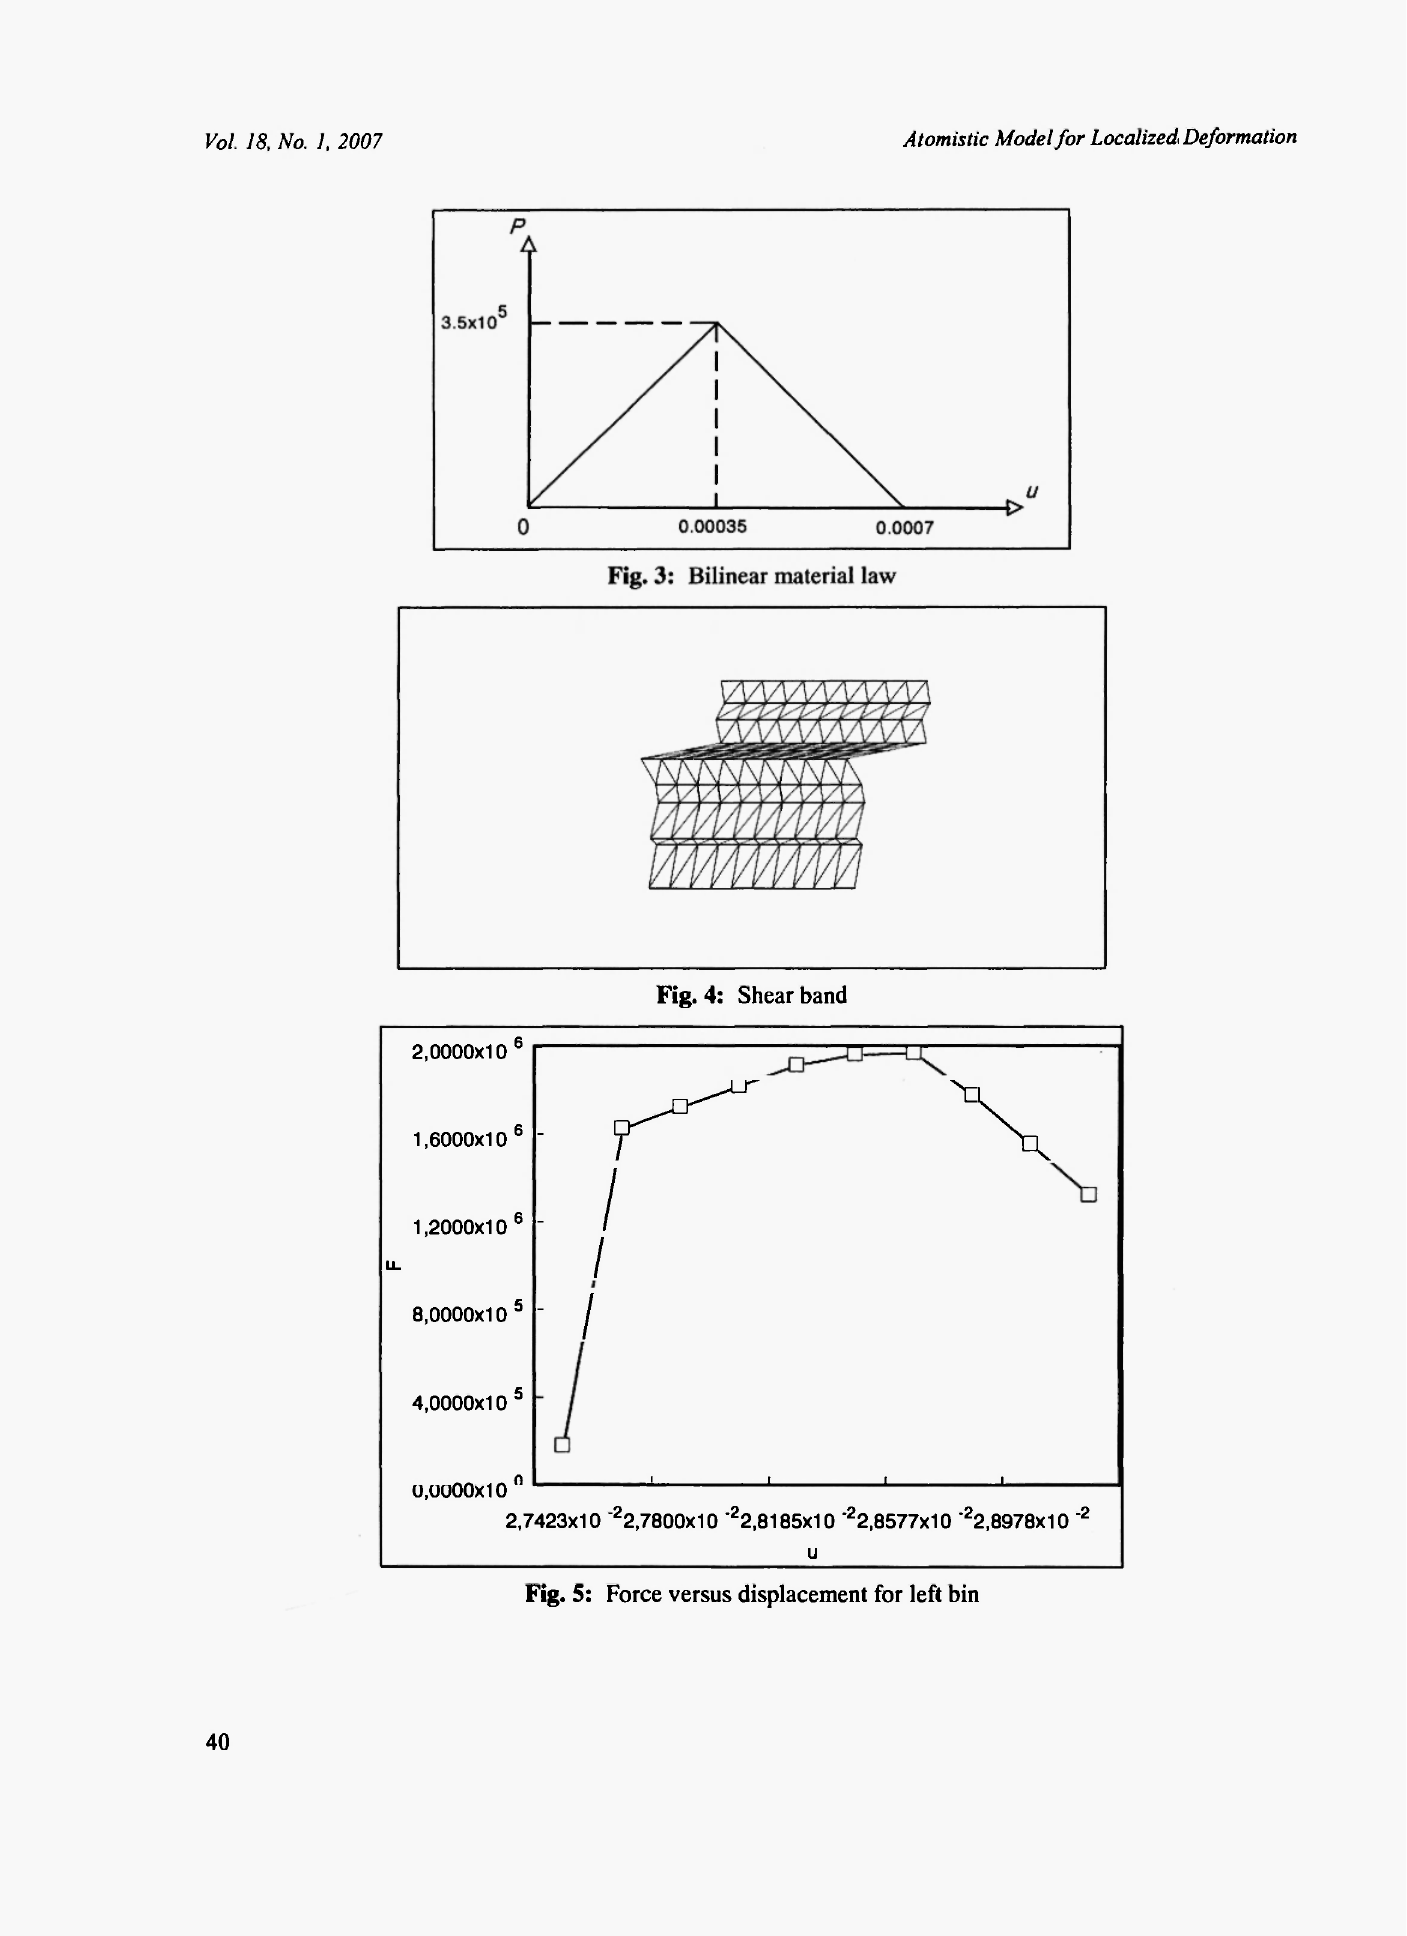
Fig. 5: Force versus displacement for left